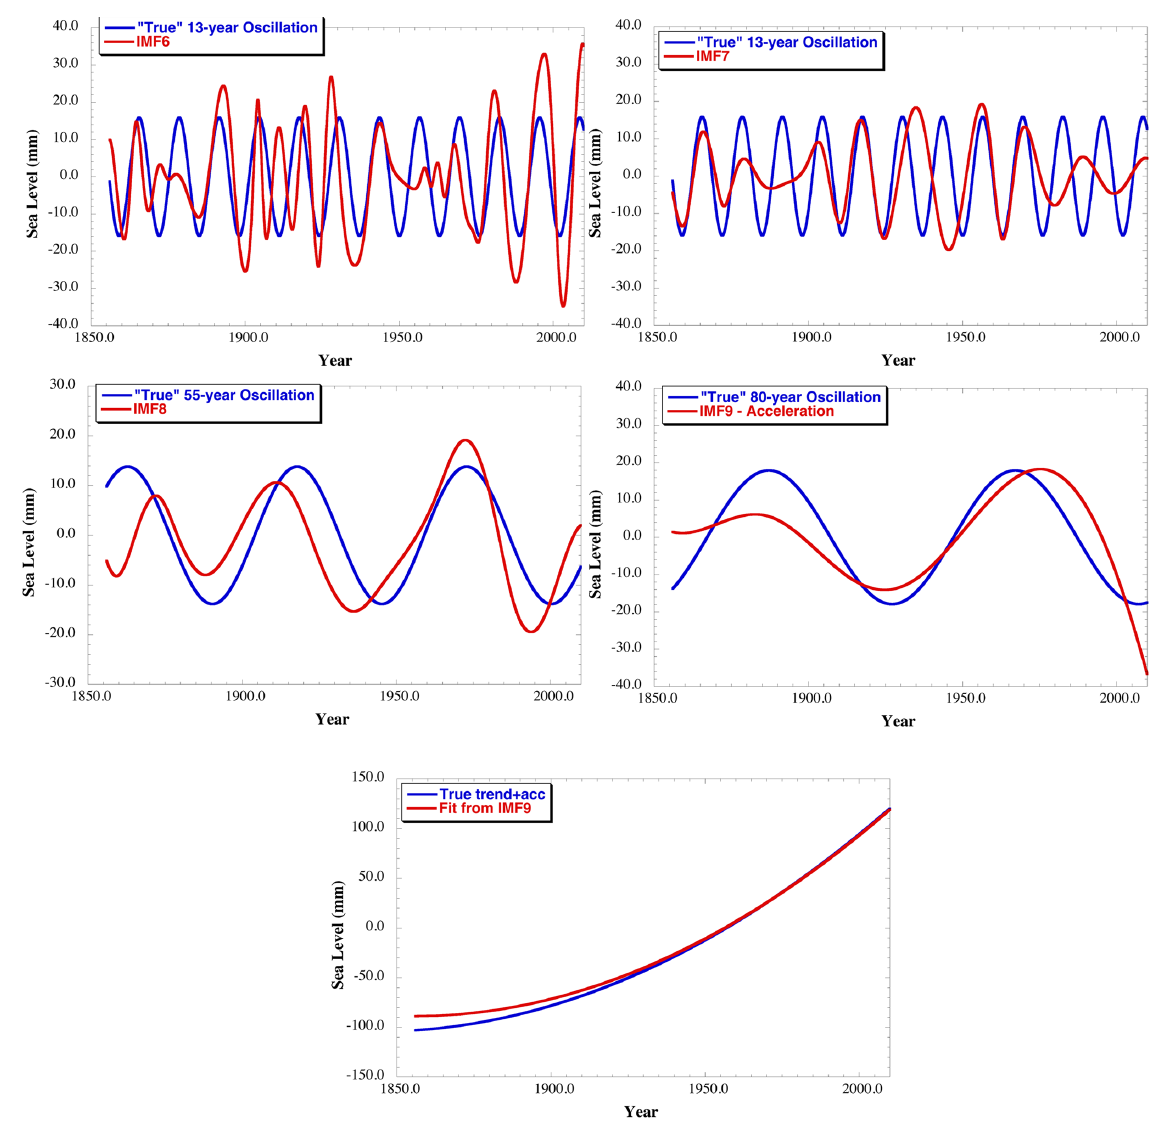
Figure 3. True oscillations and long-term trend + acceleration (red) for simulation shown in Fig. 2a, along with the closest correlating IMF